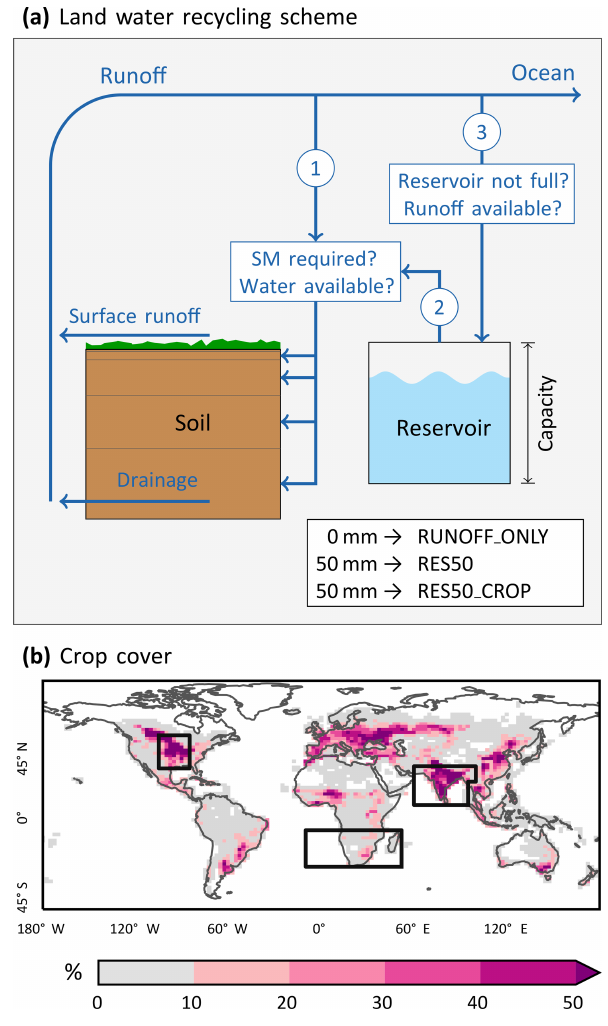
Figure 1. Land water recycling (LWR) scheme, list of experiments, and area where LWR is applied in the RES50_CROP experiment (see Sect.2.3). (a) Illustration of the LWR scheme used in this study, and list of the reservoir capacity for each of the experiments. The blue lines indicate the “flow” of water in the algorithm: sur- face runoff is combined with sub-surface drainage resulting in to- tal runoff. If SM is below the target threshold, this total runoff is used to water the soil (1). When not enough runoff is available, wa- ter is taken from the reservoir (2). Finally, any remaining runoff is then used to fill up the reservoir if necessary (3). Note that steps (2) and (3) are only carried out if the reservoir capacity is > 0mm. (b) Crop fraction in CLM in the year 2000. In RES50_CROP, LWR is applied in all grid cells with more than 10% crop fraction. The black boxes in (b) show the three regions presented in Fig. 5: central North America (CNA), South Asia (SAS), and South Africa